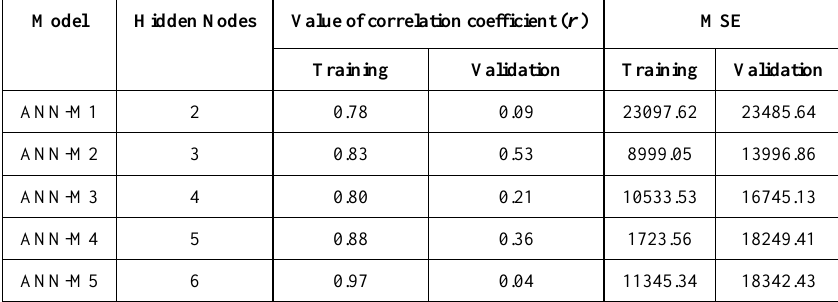
Table 2. Performance statistics for various ANN